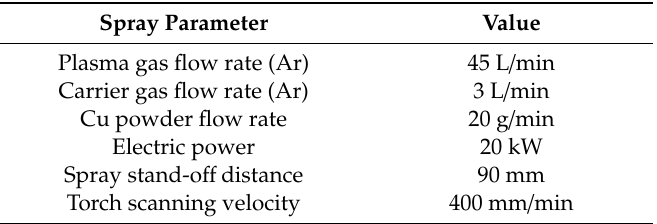
Table 2. Plasma spray parameters of Cu interlayer.